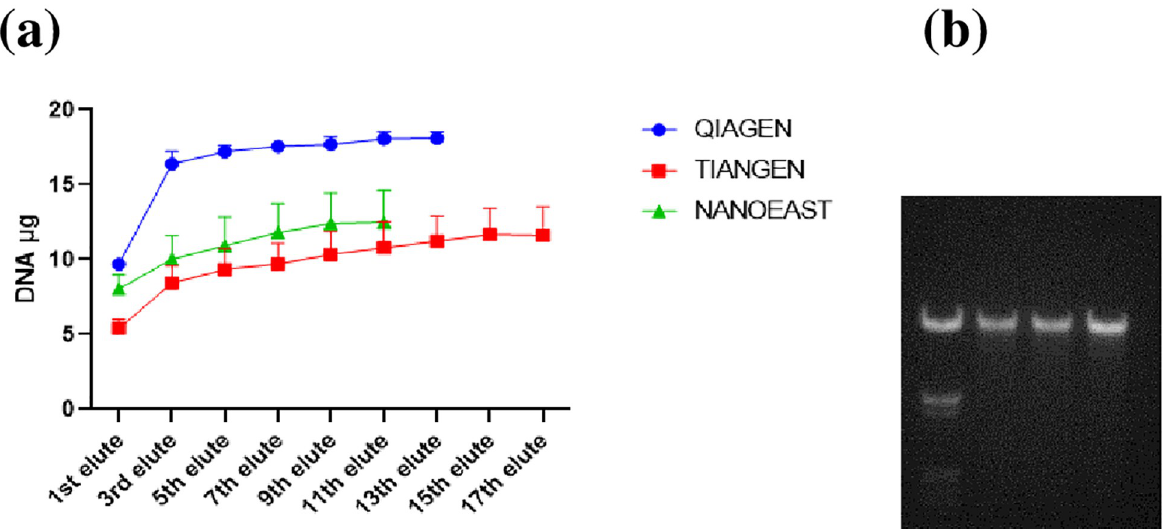
Fig 2. (a) The amount of extracted DNA during repeated serial elutions among TIANGEN, NANOEAST and QIAGEN. (b) DNA electrophoresis of the related samples (Marker,TIANGEN, NANOEAST and QIAGEN). https://doi.org/10.1371/journal.pone.0277138.g002 detected for BEYOTIME and AIDLAB. The OD260/OD230 ratios of NANOEAST and QIA- GEN were less than 2.0 while those of BEYOTIME, AIDLAB and TIANGEN fell between 2.0 and 2.6 (Fig 1c). When both purity indexes were comprehensively considered, only TIANGEN and BEYOTIME passed. Falling within the CC and MB methods, QIAGEN, TIANGEN and NANOEAST were selected for comparison in the experiments that were to follow. The toxic solution based BEYOTIME (chloroform) and AIDLAB approaches were excluded. The sta- tuses of the current DNA extraction approaches are summarized (Table 4 & S4 Fig).